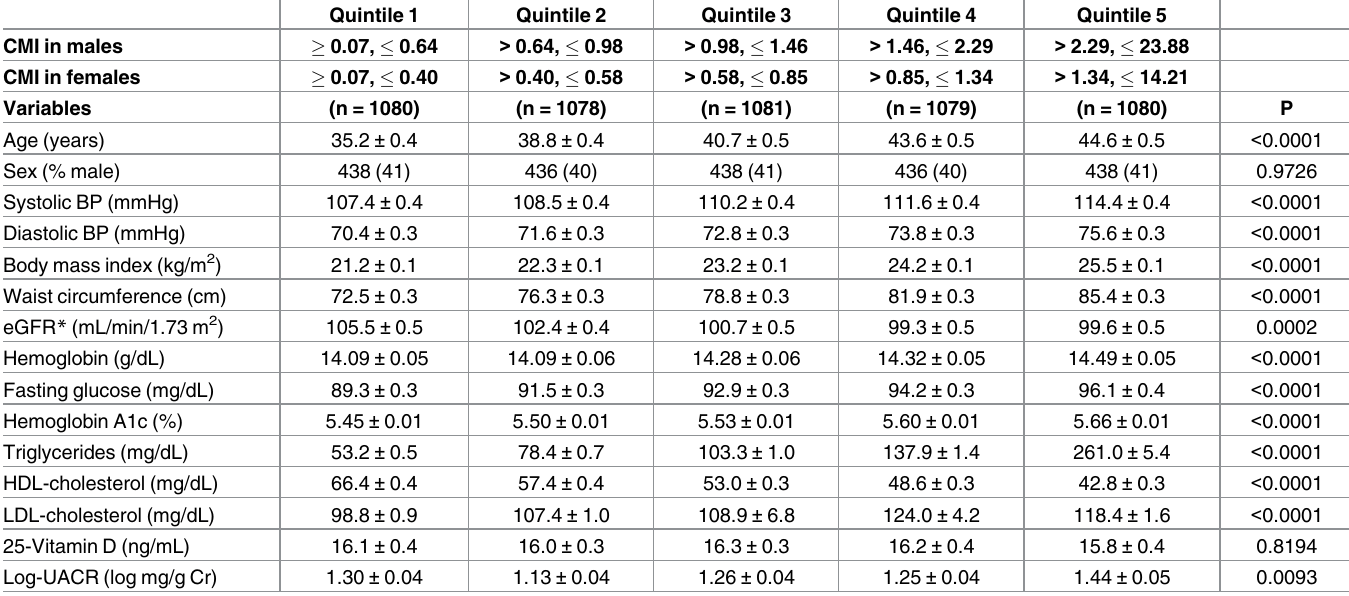
Table 1. General characteristics of the study cohort grouped according to cardio-metabolic index (CMI). Quintile